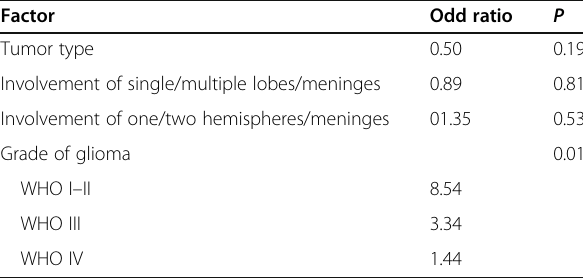
Table 6 Regression analysis of factors for